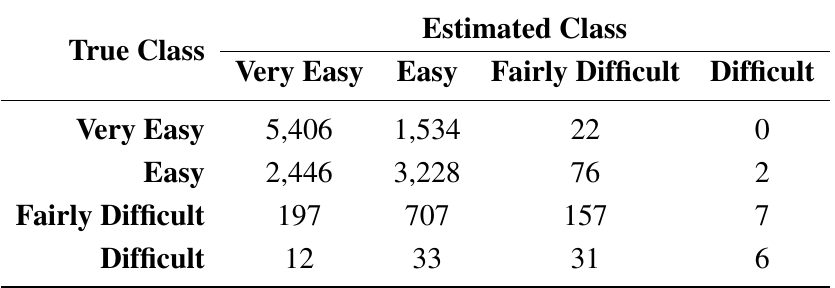
Table 8. Confusion matrix for system #2T1 on training corpus on task 1.